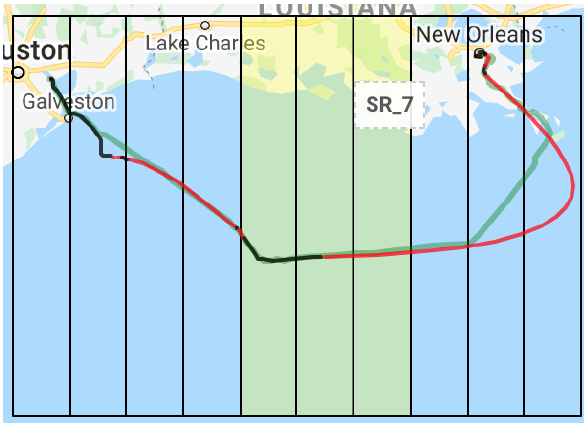
Figure 4. A trajectory example (ID is equal to 2187). The trajectory in green is the mean trajectory between two ports. The trajectory in black and red is trajectory selected, where the red indicates positions interpolated and the black indicates positions where AIS messages were